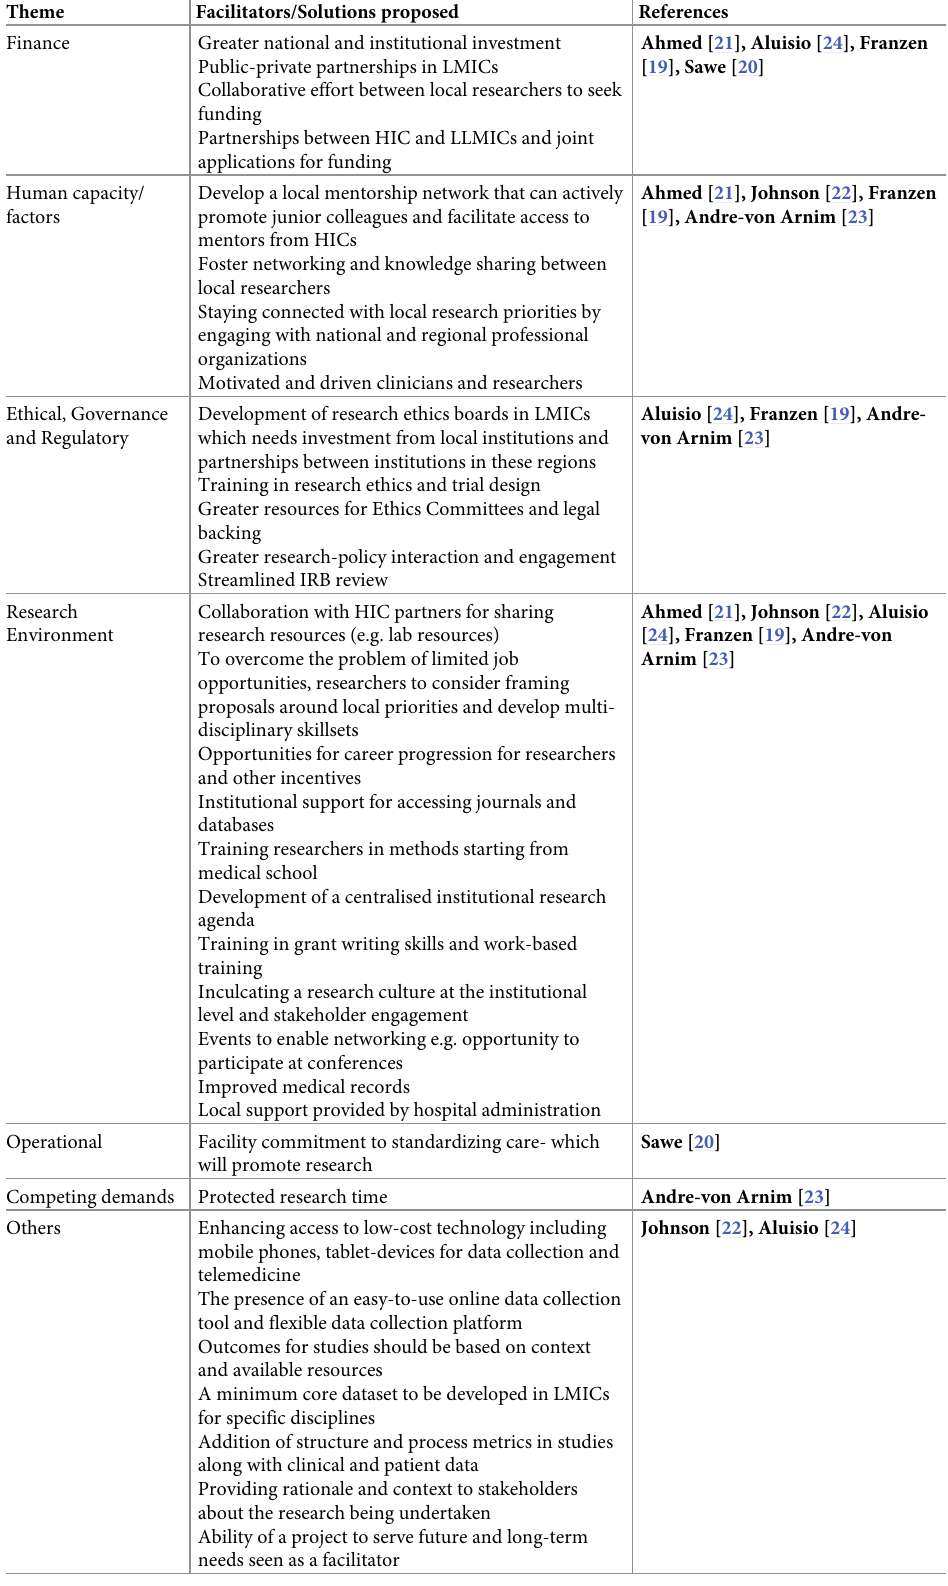
Table 3. Facilitators and proposed solutions for the conduct of critical care research in